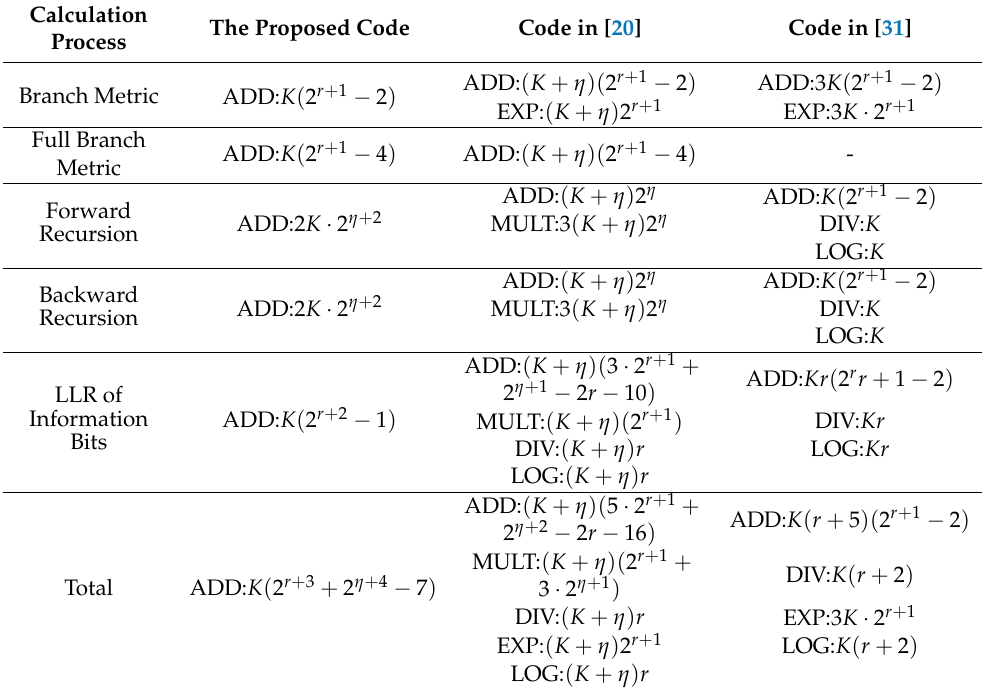
Table 1. Comparison of decoder complexity *.